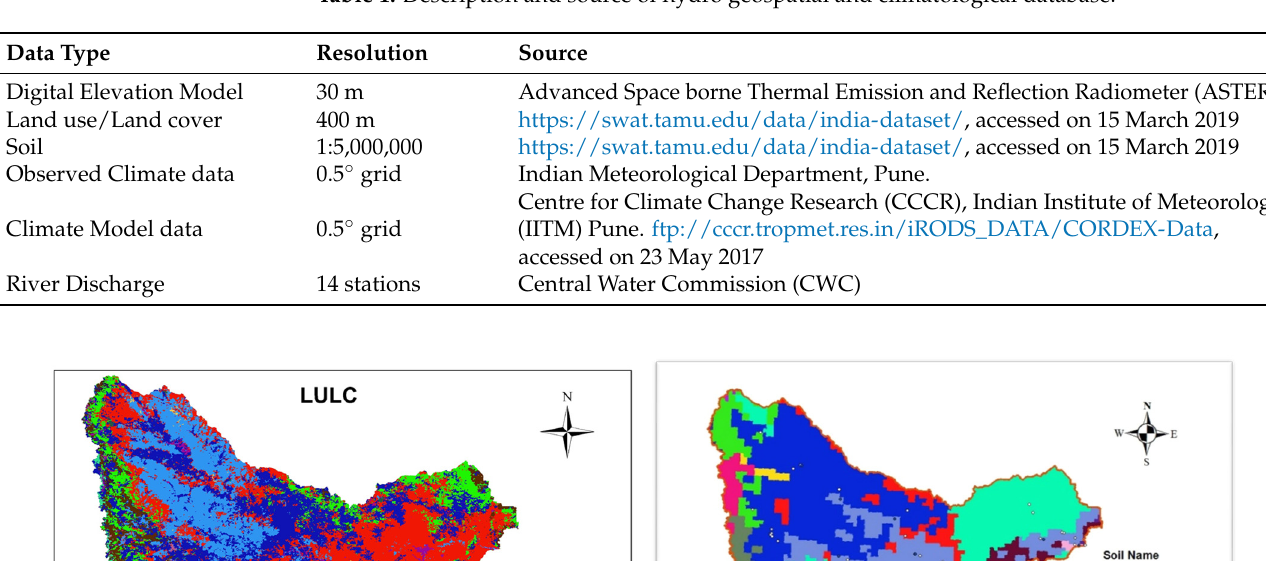
Table 1. Description and source of hydro geospatial and climatological database.